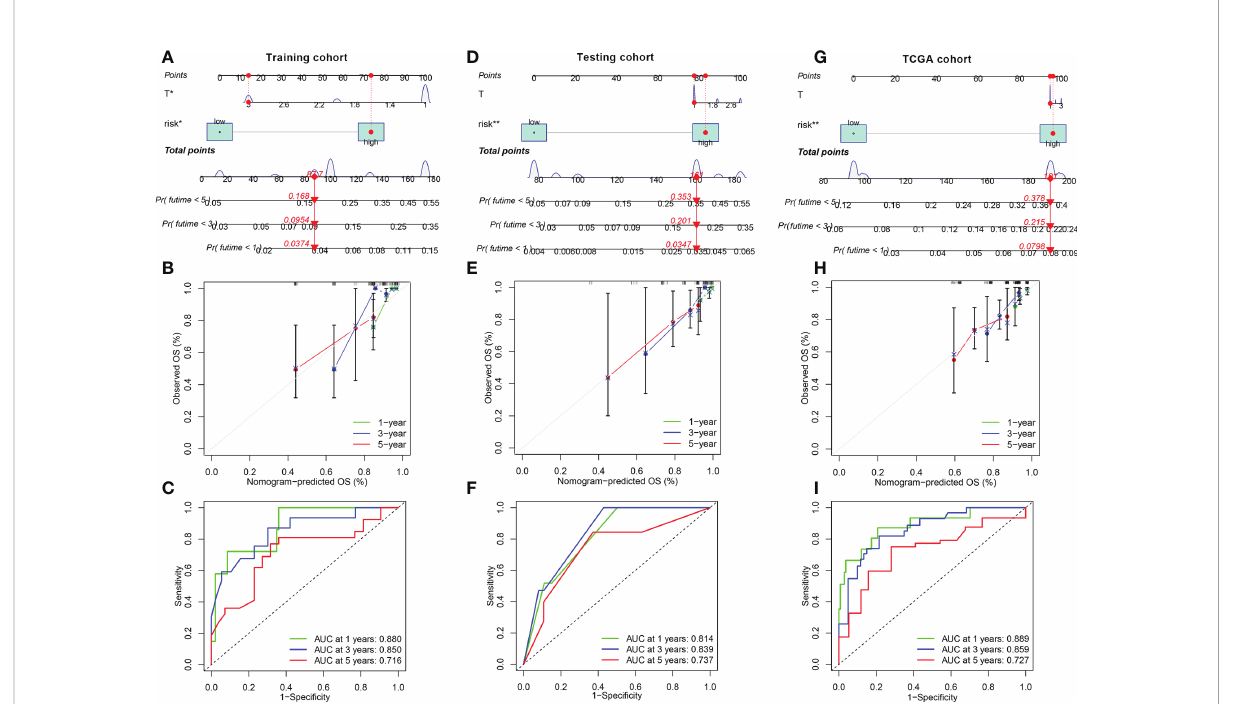
FIGURE 5 Construction and calibration of nomogram (A, D, G) Nomogram integrating FRGPI (risk) and other independence clinical prognostic characteristics in the training, testing and TCGA cohorts. (B, E, H) Calibration of the nomogram at 1-year, 3 ‐ year and 5 ‐ year survival in the training, testing and TCGA cohorts. (C, F, I) ROC curve analysis of the nomogram at 1, 2, and 3 years for KIRP patients in the training, testing and TCGA